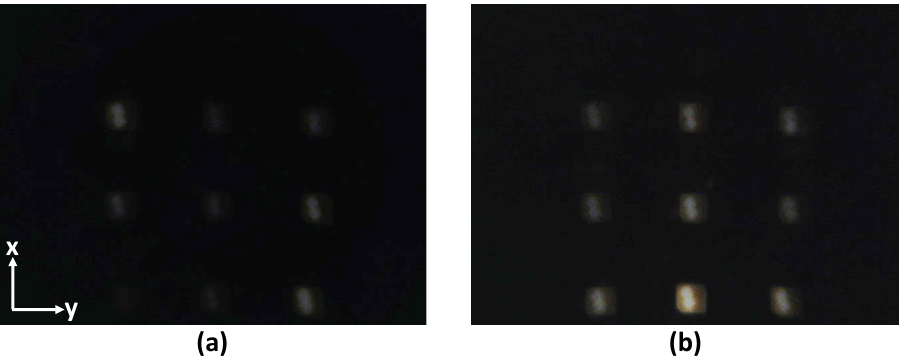
Figure 4. Two samples from the camera views: ( a ) resting state (average intensity = 5.99, the amplitude of applied force is zero) and ( b ) deformed state (average intensity = 13.45, the